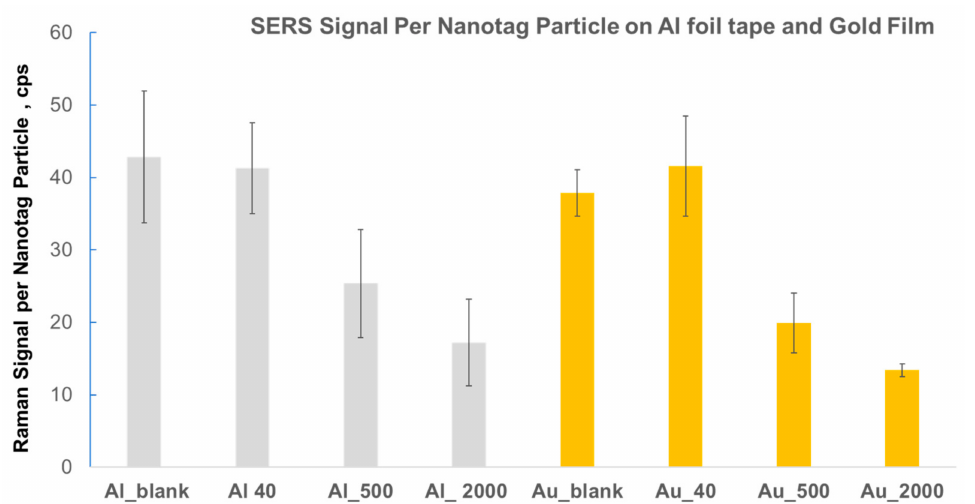
Figure 6. Raman signals per nanotag particle (for laser beam area: 1 µ m 2 ) calculated from SEM characterization of human IgG assay on gold film vs. Al foil tape. As an example of the nomenclature, Au_40 shows the 40 pM concentration of human IgG on gold